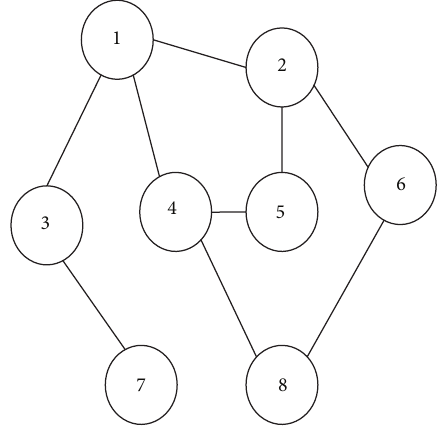
Figure 1: Communication graph.